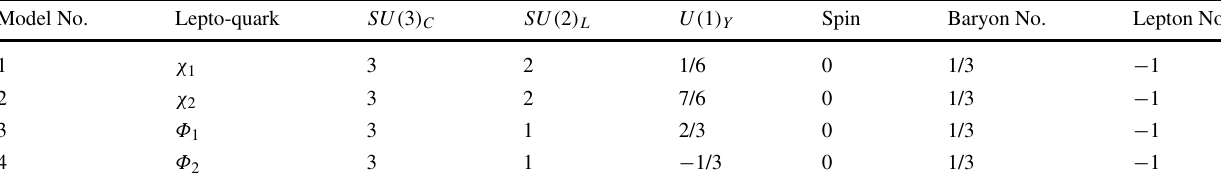
Table 38 Quantum numbers of various lepto-quark fields under the SM gauge groups, their spins and baryon and lepton numbers Model